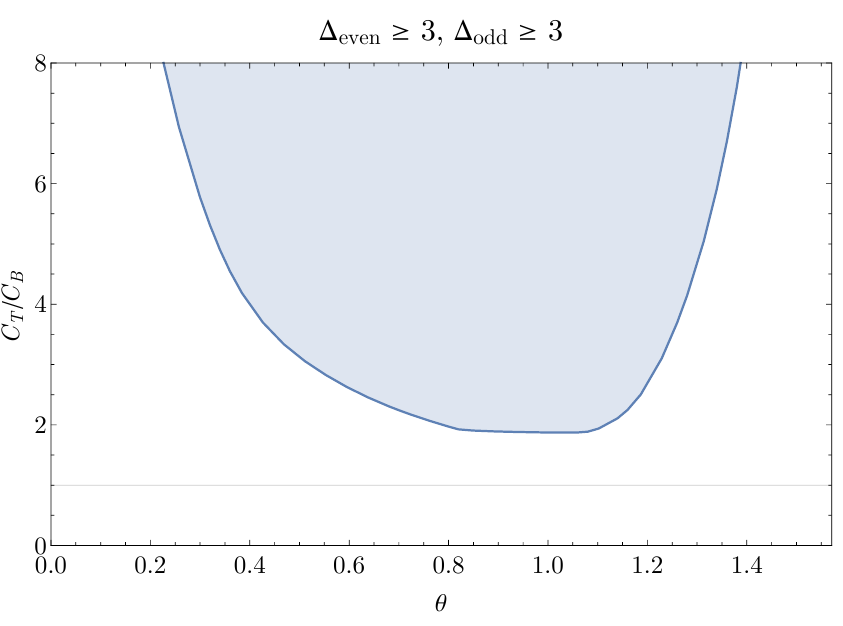
Figure 7 . Lower bound on C T as a function of (cid:18) assuming no relevant scalar operators. this plot that such theories must have C to lie towards the middle of the range [0 ; (cid:25)=